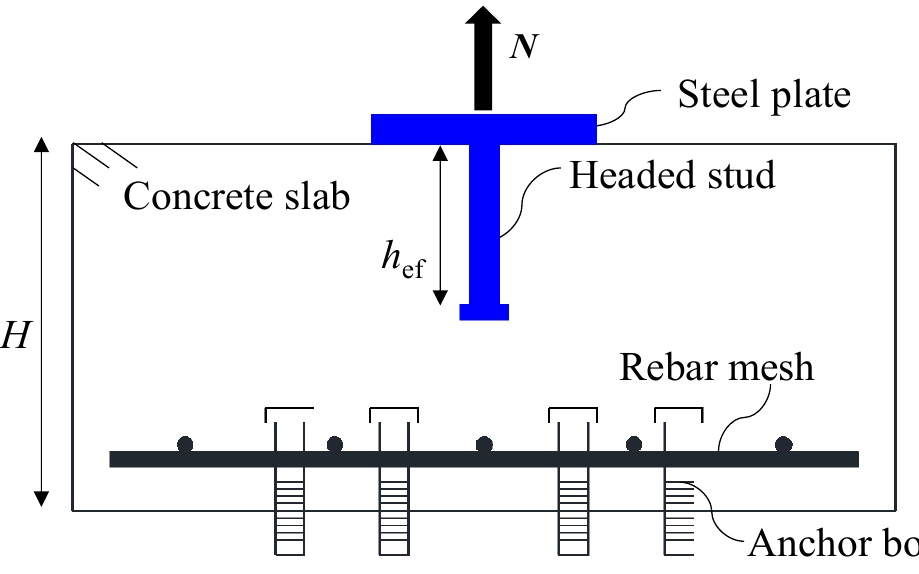
Figure 2. Schematic representation of the specimen.